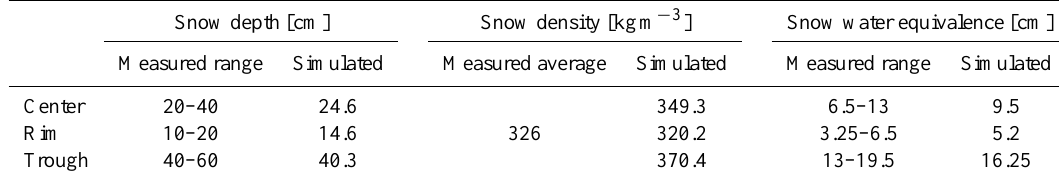
Table 3. Measured snow depth ranges were gathered from a compilation of 258 snow depth measurements taken on 2 May 2013 in the area encompassing all three borehole temperature measurements. universal transverse mercator (UTM) coordinates: Northing 7910330-7910350 and Easting 585900-585930. Measured snow water equivalence (SWE) ranges were calculated from measured snow depth and the measured average snowpack density of 326kgm − 3 . All simulated values were taken on simulation day 2 May 2013.